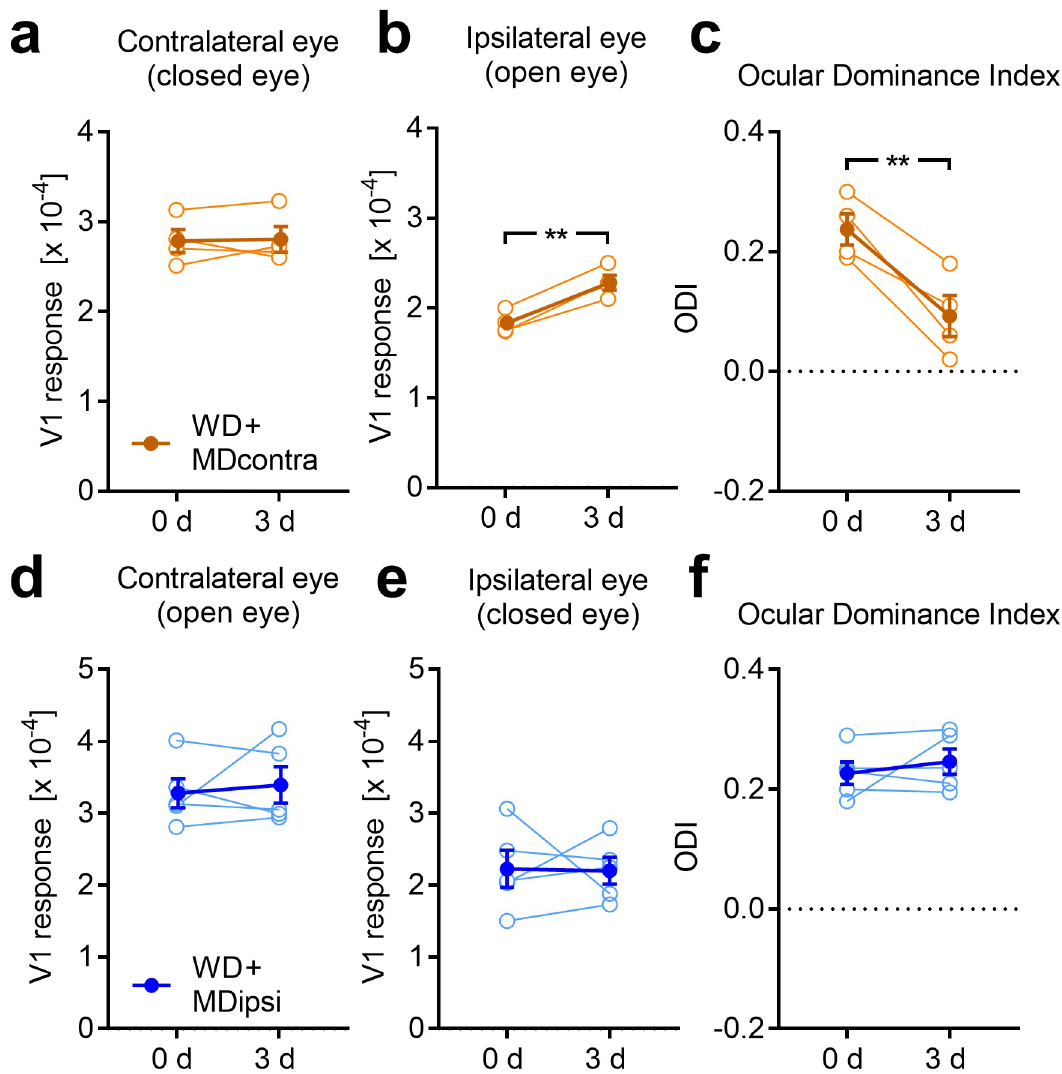
Fig 6. Cross-modally induced ODI shift requires patterned vision through the ipsilateral eye. ( a ) Combining WD with a MD of the contralateral eye (n = 4) did not lead to changes of V1 responses evoked by the contralateral eye between 0 and 3 days after WD. ( b ) However, there was a significant increase of V1 activity elicited by visual stimulation of the ipsilateral eye, like found after WD only. ( c ) Thus, the ODI markedly shifted towards zero. ( d, e ) In contrast, if we combined WD with a MD of the ipsilateral eye (n = 5), V1 activity evoked by both contra and ipsilateral eye stimulation remained statistically unchanged after 3 days. ( f ) Moreover, there was no ODI shift after this treatment suggesting that patterned vision through the ipsilateral eye is required for cross-modally induced OD shifts. Open circles represent measurements of individual animals. Closed circles represent the means of each group ± s. e.m.; � p < 0.05, �� p < 0.01.